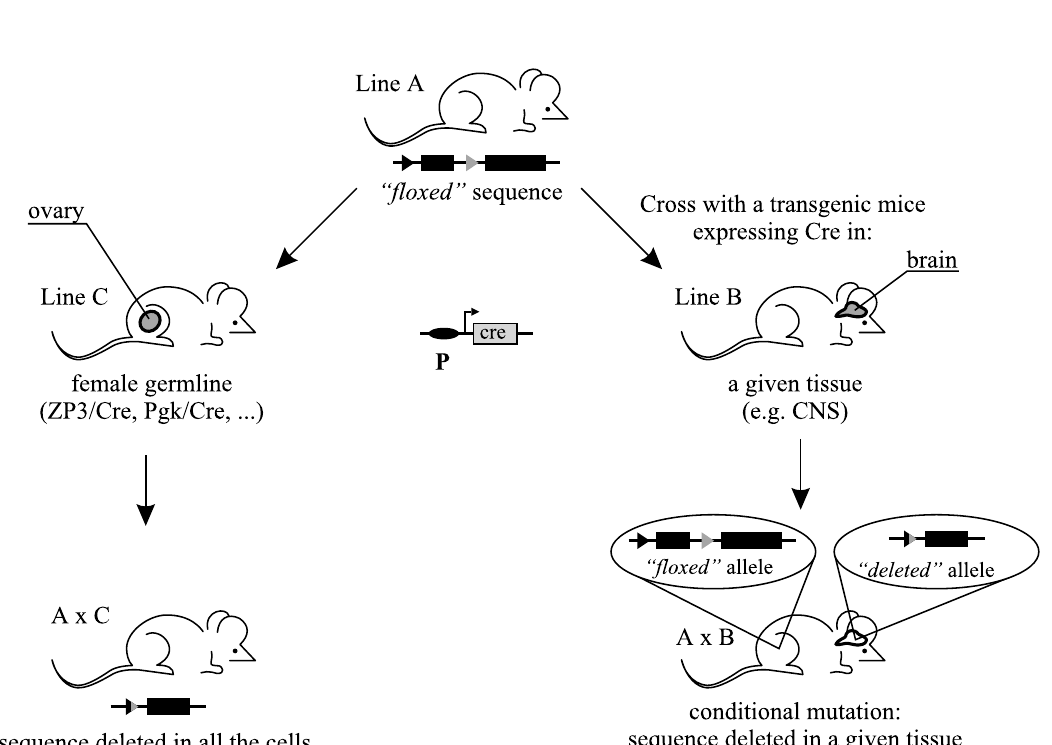
Fig. 5 – The Cre/ loxP system in vivo. The Cre/ loxP system can be used directly in the mouse. The most common applications of this approach are illustrated in this figure and require the use of two types of mouse. The first mouse (line A), obtained after homologous recombination in the ES cells, carries in its genome a ‘‘floxed’’ sequence (exons, regulatory sequences, promoter, selection cassette,...). The other is a transgenic mouse expressing the Cre recombination under the control of a given promoter. If this promoter directs the expression of Cre in the female germ line (strain C), the animals issued from a cross between a female C and a male A will carry the deletion in all their cells, the recombination event having taken place at the zygote stage through the recombinase accumulated in the oocyte. If the promoter directs the expression of Cre in one or several cell types (strain B), the animals born from a cross between a mouse A and a mouse C will be mosaics: the cell types expressing the recombinase will carry a deleted allele whereas the other cells of the animal will carry a ‘‘floxed’’ allele. CNS: central nervous system; P: